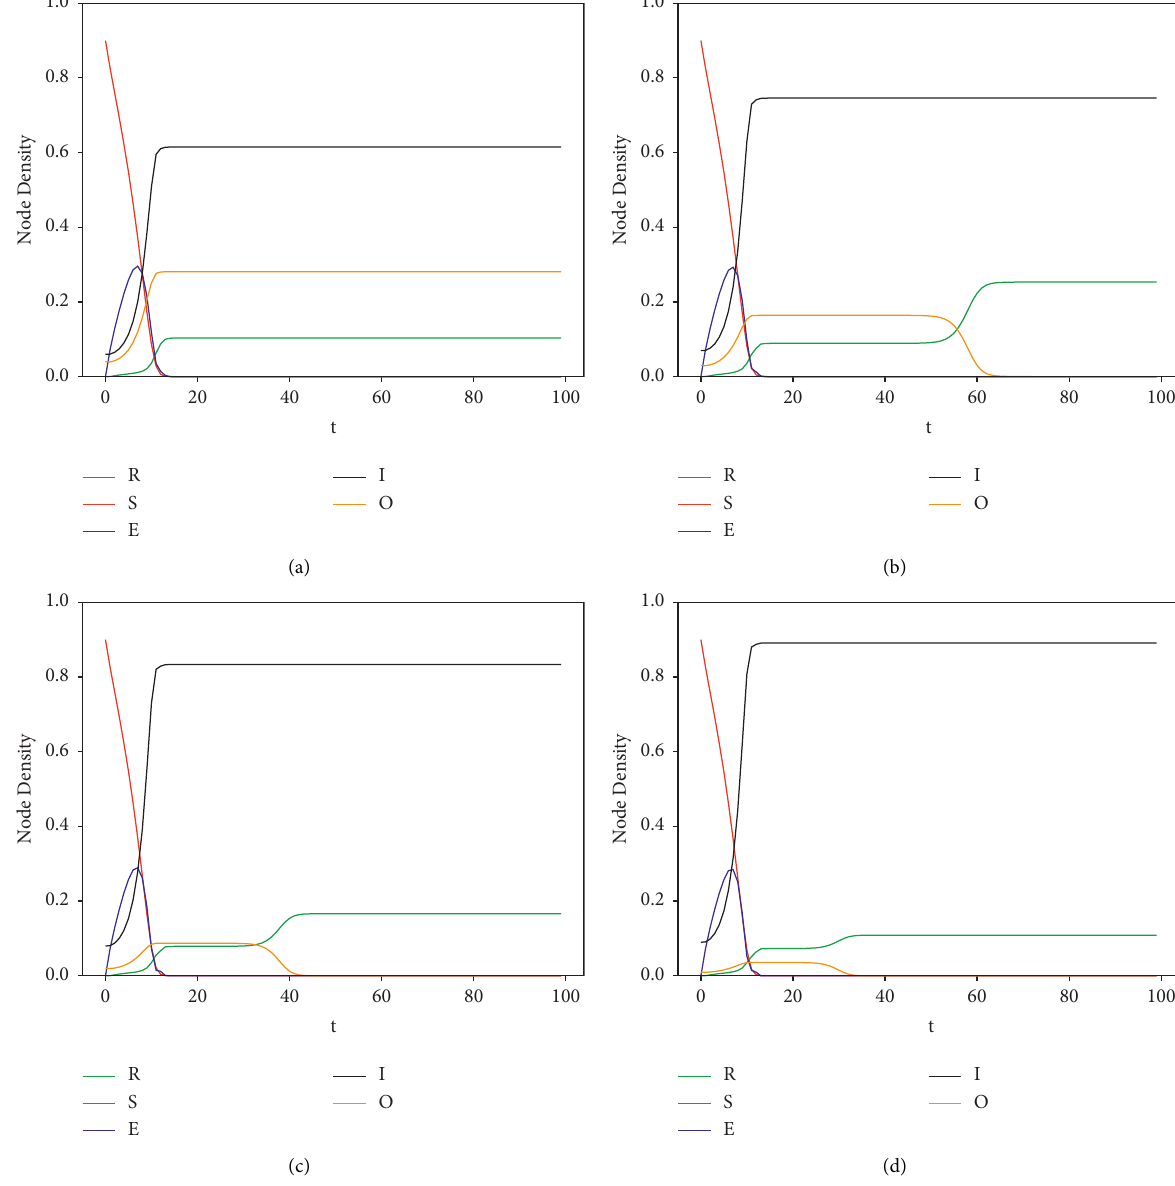
Figure 4: The influence of the initial density ratio of A and O on the density of various nodes. (a) ( O ( 0 ) / A ( 0 )) � 4/6. (b) ( O ( 0 ) / A ( 0 )) � 3/7. (c) ( O ( 0 ) / A ( 0 )) � 2/8. (d) ( O ( 0 ) / A ( 0 )) � ( 1/9 )